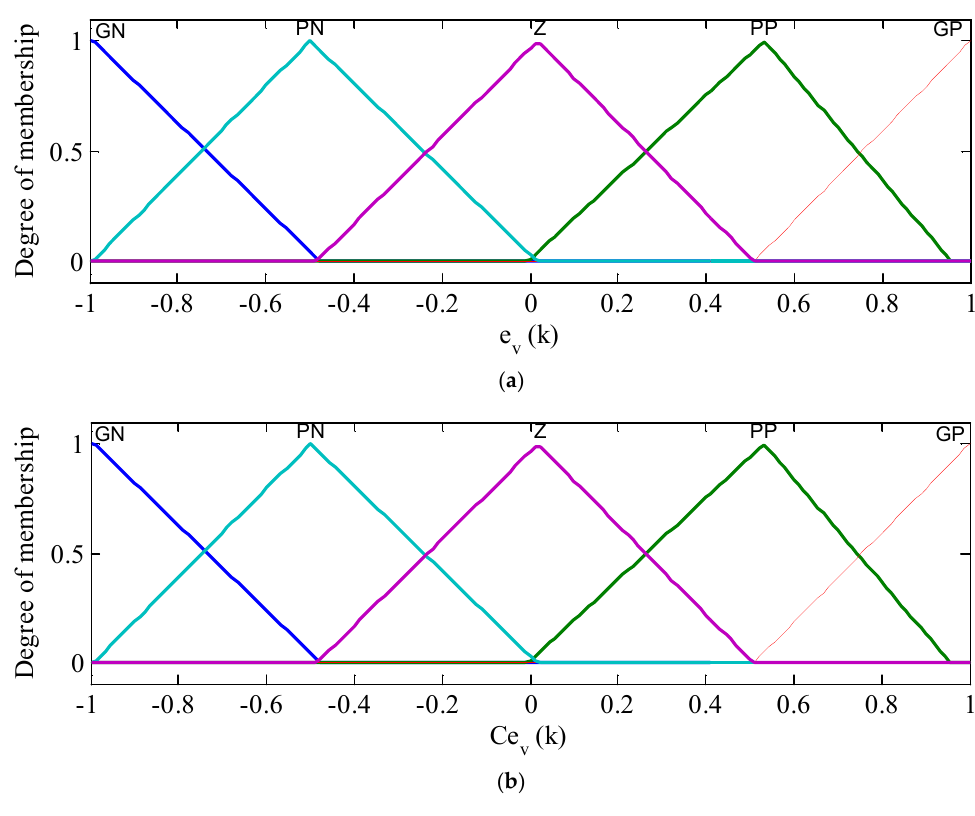
PP GPPN Z Figure 5. Cont